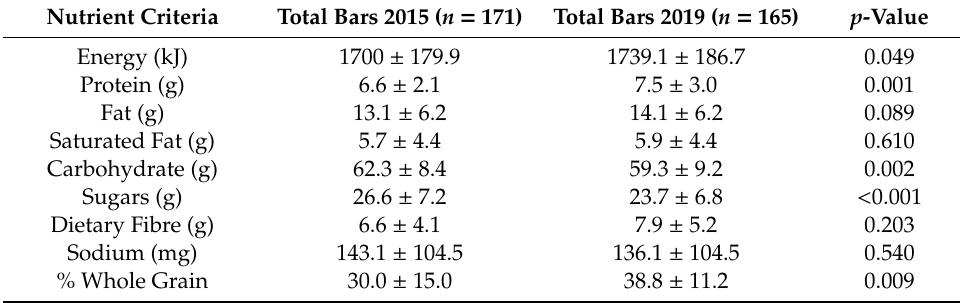
Table 6. Comparison of nutrients and whole grain in total bars between 2015 and 2019 per 100g (mean and